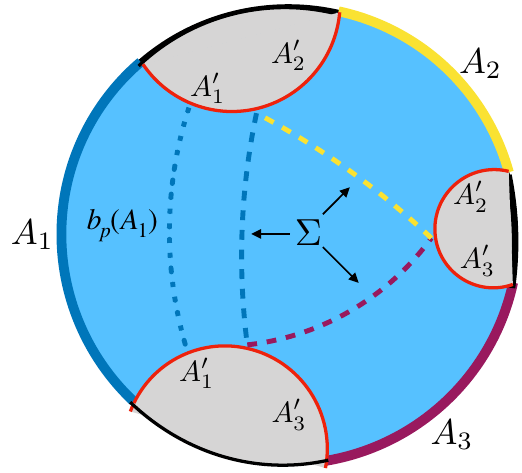
Figure 2 . The holographic multipartite EOP proposal of [20], illustrated for the case of three := m ( regions. The joint RT surface ) is shown in red. This is partitioned into regions A 0 , and i O A the total area of the corresponding minimal surfaces m ( A i A 0 ) is minimized over partitions. The i minimal surfaces (cid:6)( A i ) are shown as colored dashed lines; their union is (cid:6). Also shown as a dotted line is the minimal surface b p ( A 1 ) which computes the bipartite EOP E w ( A 1